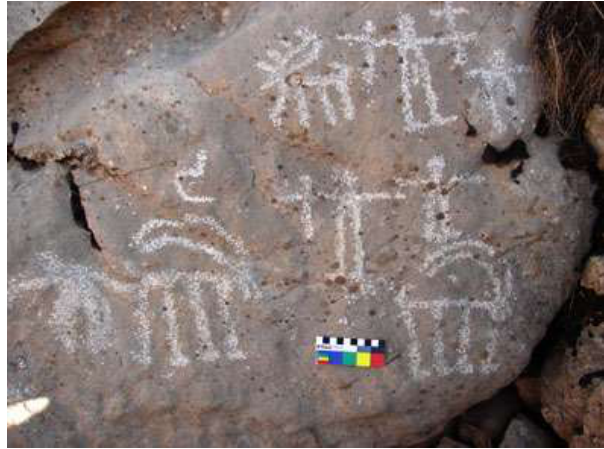
Figure 6. Hawraman, Dala Marz village, Doul-Havar, a “scene” including anthropomorphs, zoomorphs and a human shape holding an arrow in the bow with stretched